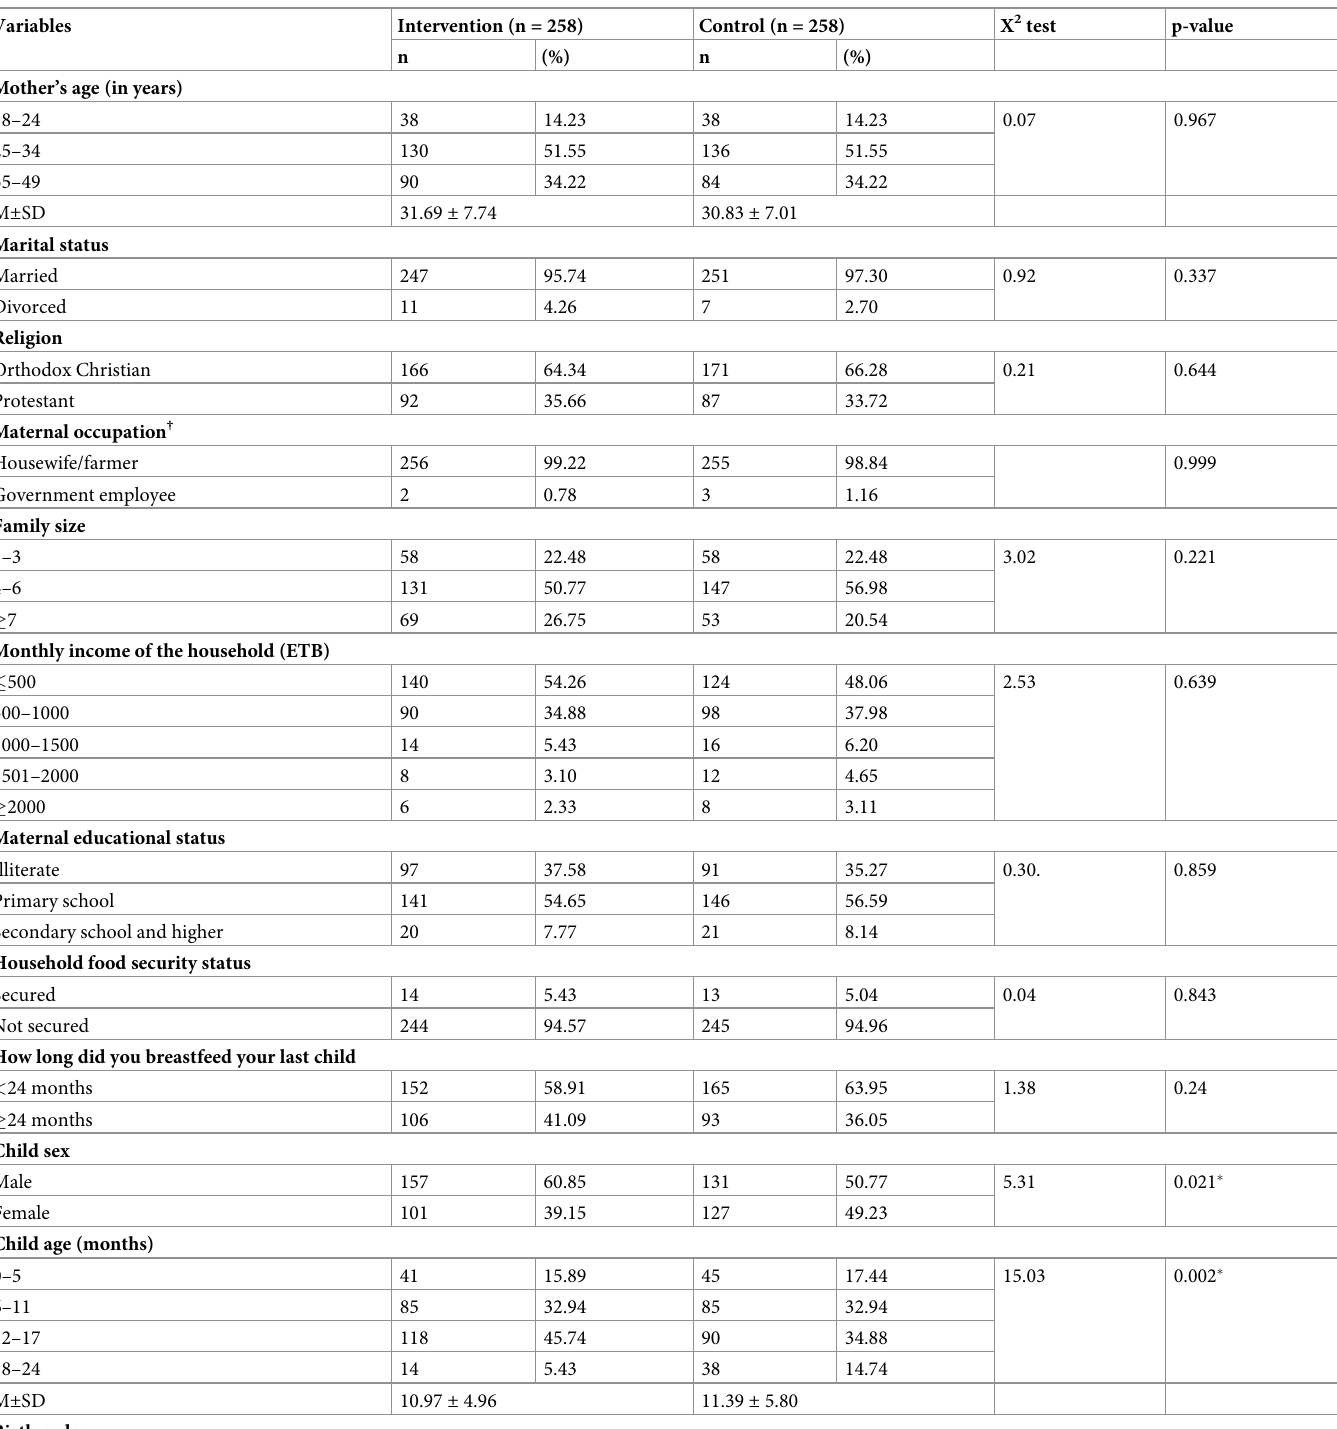
Table 1. Socio-demographic characteristics of mothers, in Southwest